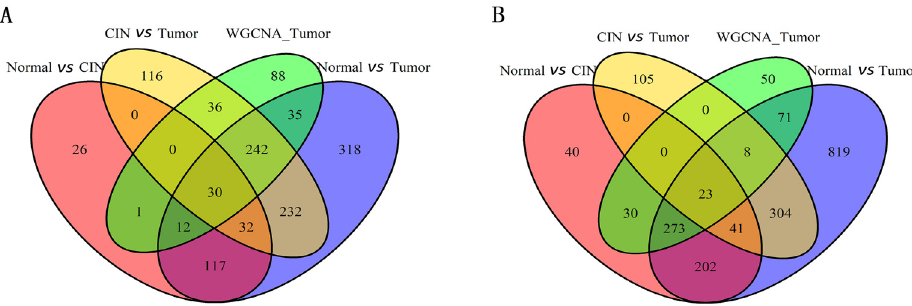
Figure 3. Identi fi cation of coexpressed differentially expressed genes (DEGs). A and B , Venn diagrams show downregulated and upregulated genes from both DEGs by weighted coexpression network analysis (WGCNA) and the edgeR package in R. Intersected areas represent the common DEGs in both databases. CIN: cervical intraepithelial